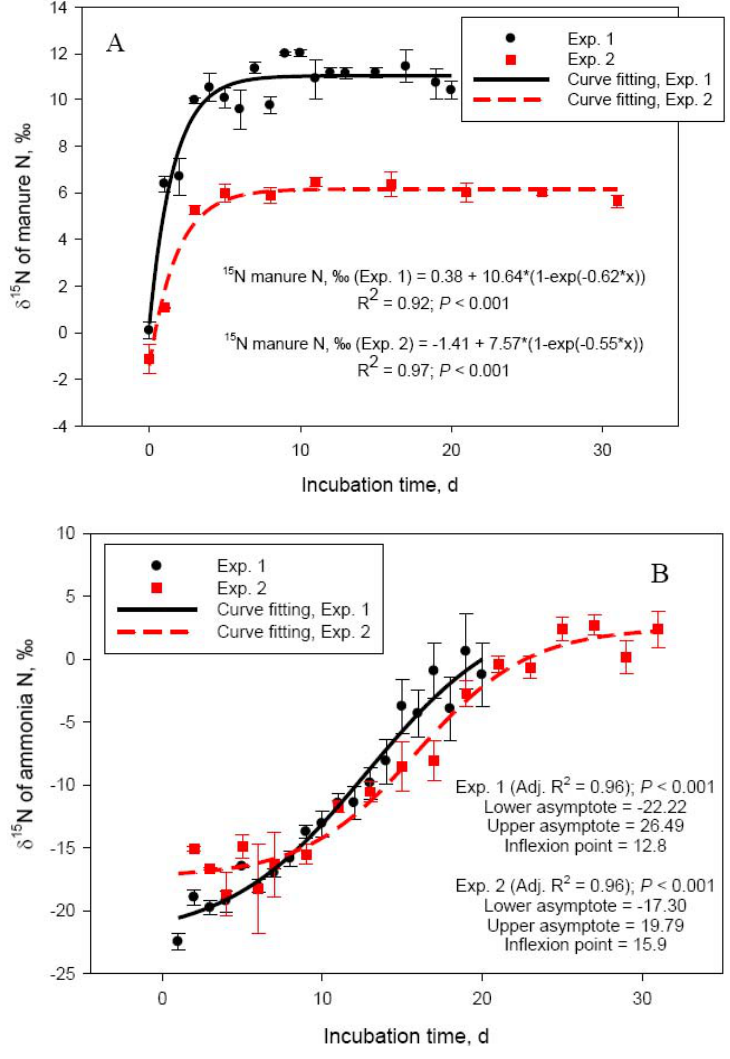
Figure 2. δ 15 N (‰) of manure- ( A ) and ammonia-N ( B ) in Exp. 1 and 2 (means ± SE; n =